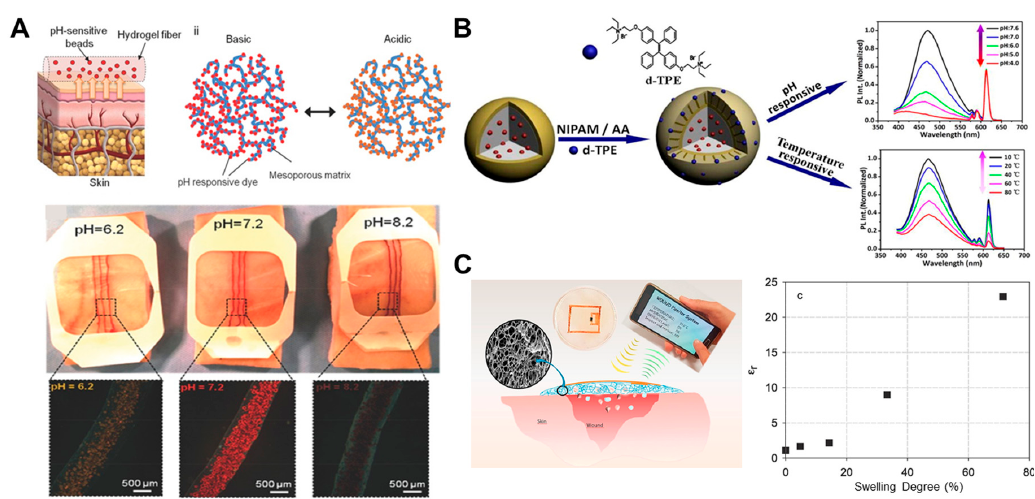
Figure 7. Hydrogel monitoring of pathological skin conditions through general indicators including pH, temperature, and moisture. ( A ) pH-responsive hydrogel fibers enable long-term monitoring and an on-site readout of the epidermal wound condition, through incorporation of mesoporous nanoparticles containing the pH-sensitive dye. Reproduced with permission from [141]. Copyright © 2016 John Wiley and Sons. ( B ) Core–shell hydrogel particles consisting of pH- and temperature-responsive